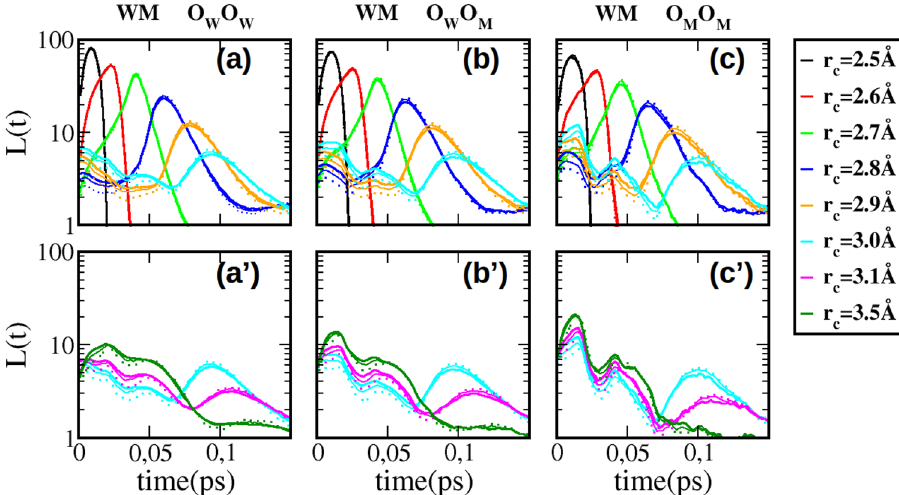
Figure 2. H-bond life time distributions L ( t ) for water–methanol (WM) mixtures, for ( a , a’ ) water–water clusters, ( b , b’ ) for water–methanol clusters, and ( c , c’ ) for methanol–methanol clusters. The upper panels ( a – c ) show the primary peak features, while the lower panels ( a’ – c’ ) show the secondary and tertiary peak features. The thick full lines are for x M = 0.2 , the thin lines for x M = 0.5 , the dotted lines for x M = 0.8